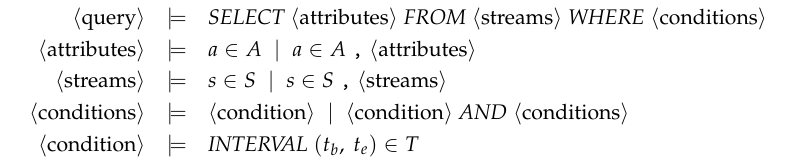
Figure 2. Theoretical grammar of queries issued on data streams. A summary of the symbols definition is listed in Table 1.